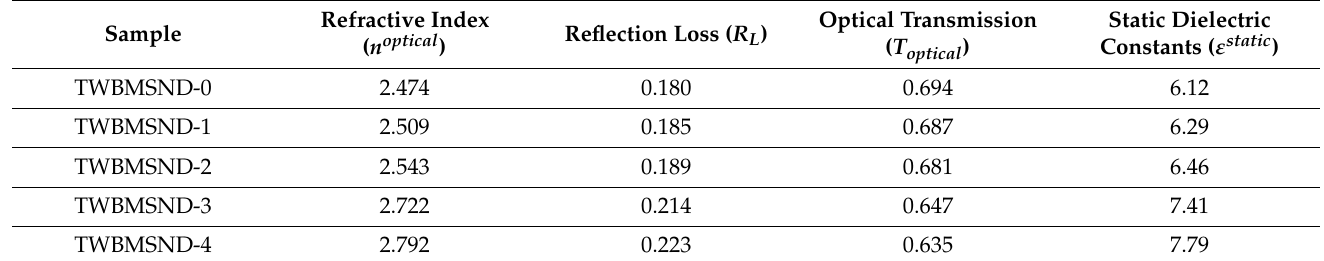
Table 2. Data on the optical characteristics of the glasses under study.